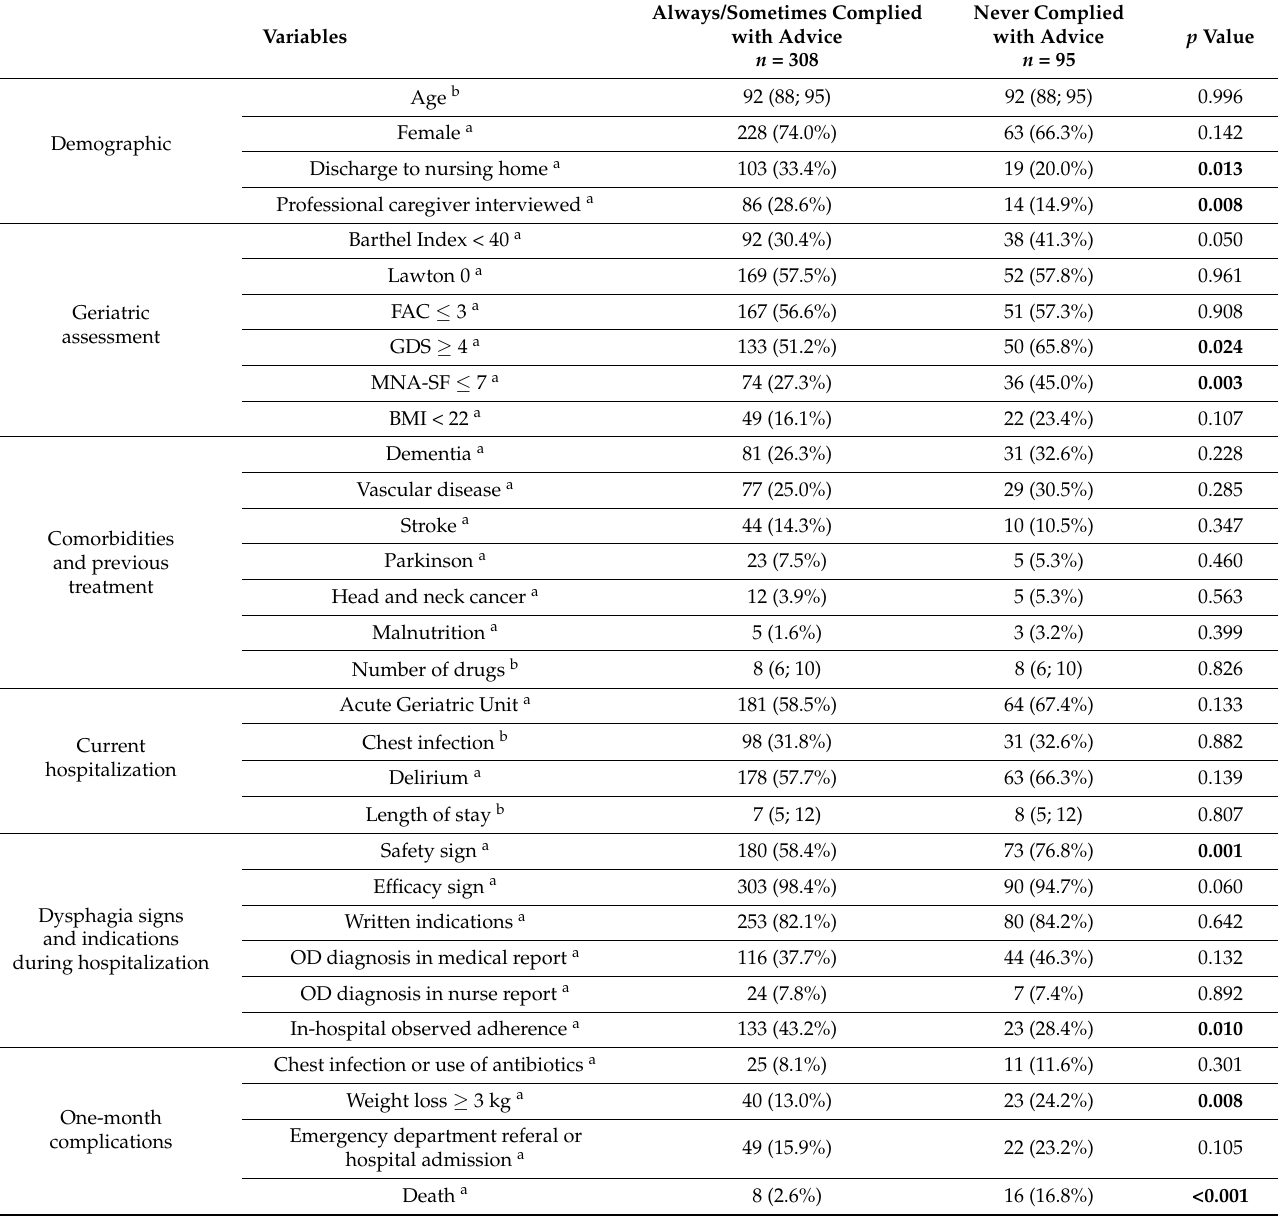
Table 2. Clinical data according to one-month self-report